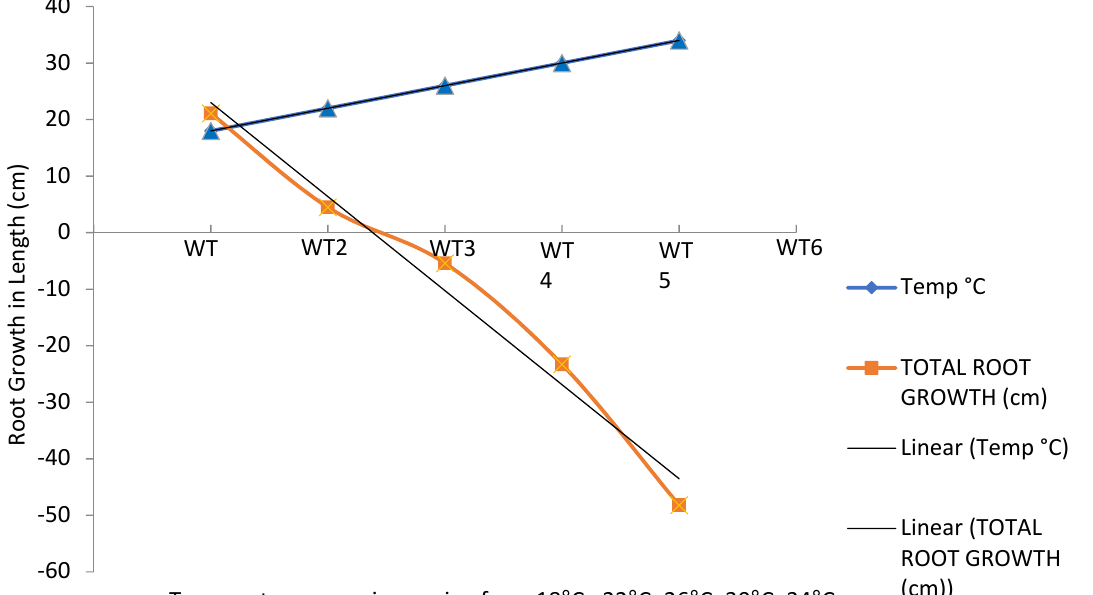
Figure 5. The relationship between root zone water temperature treatments and the relative rates of increase and decrease in root length.